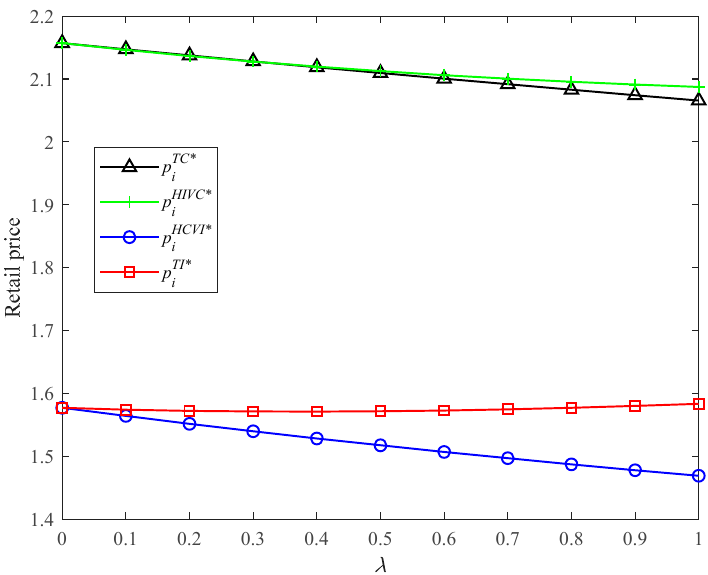
Figure 4. Retail prices in four models with different 𝜆 .